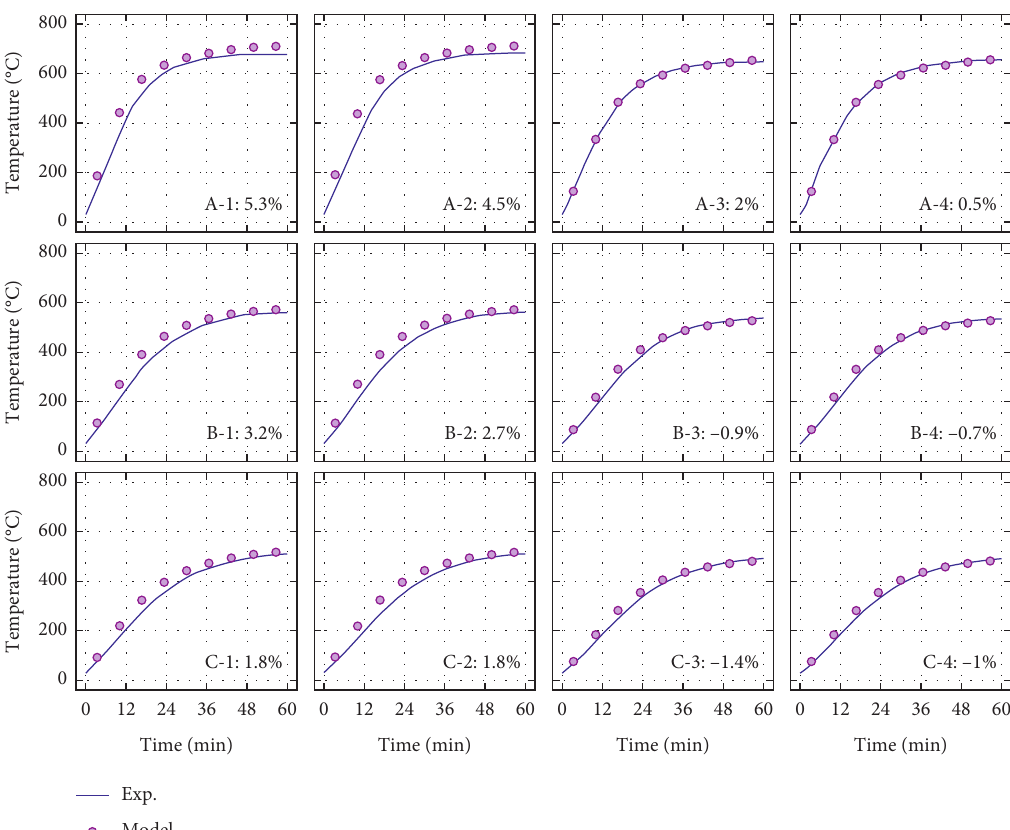
Figure 2: Comparisons between measured and calculated surface temperatures.